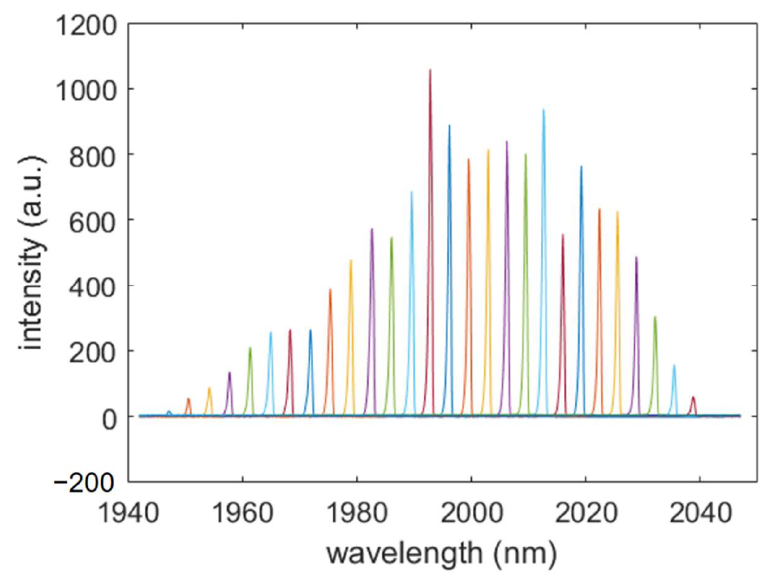
Figure 4. The spectrogram of the MOPA system.